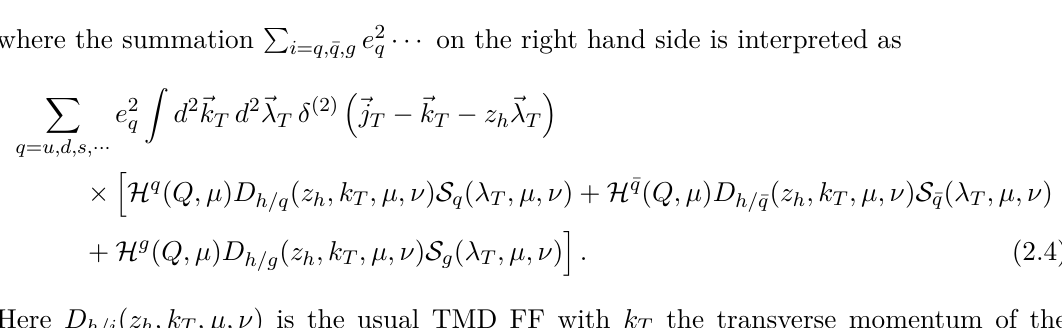
Figure 2 . Three configurations that contribute to the NLO hard function: (a) virtual correction; (b) quark q is on the right hemisphere, while both anti-quark ¯ q and gluon g are on the left hemi- sphere; (c) gluon g is on the right hemisphere, while both quark q and anti-quark ¯ q are on the left hemisphere. Note that the observed hadron is on the right